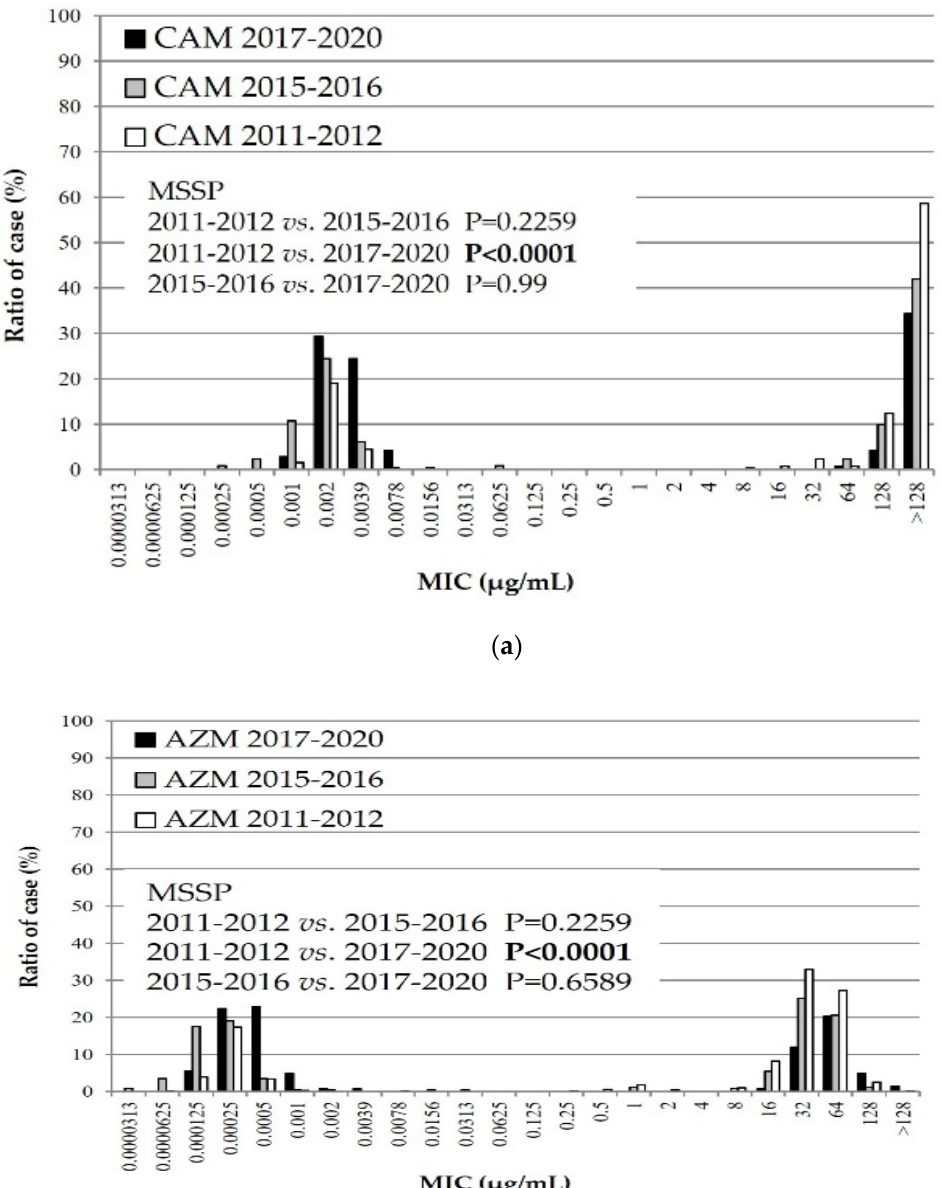
Figure 1. Minimum inhibitory concentration (MIC) distribution of macrolide agents, ( a ) CAM and ( b ) AZM, against Mycoplasma pneumoniae isolates during three periods: 2011–2012, 2015–2016, and 2017–2020. CAM: clarithromycin, AZM: azithromycin.